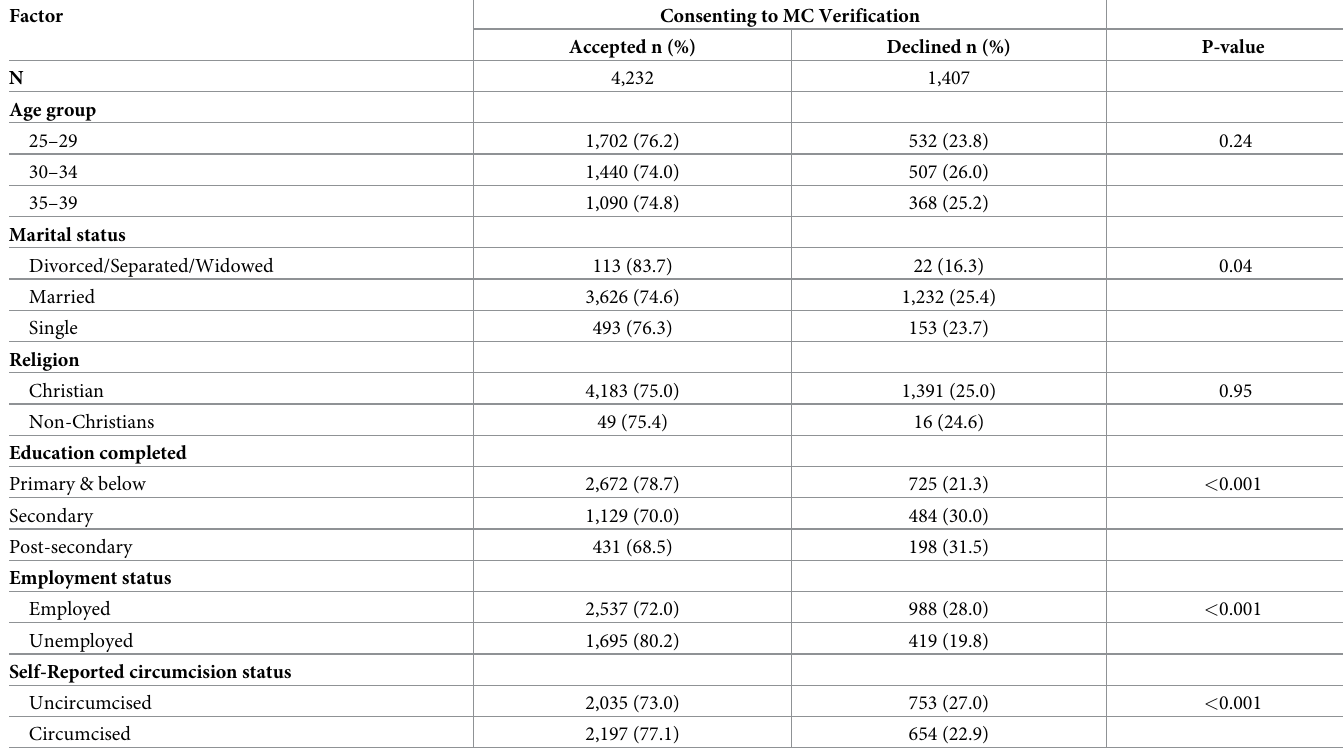
Table 1. Characteristics of men enrolled in the study (n = 5,639).